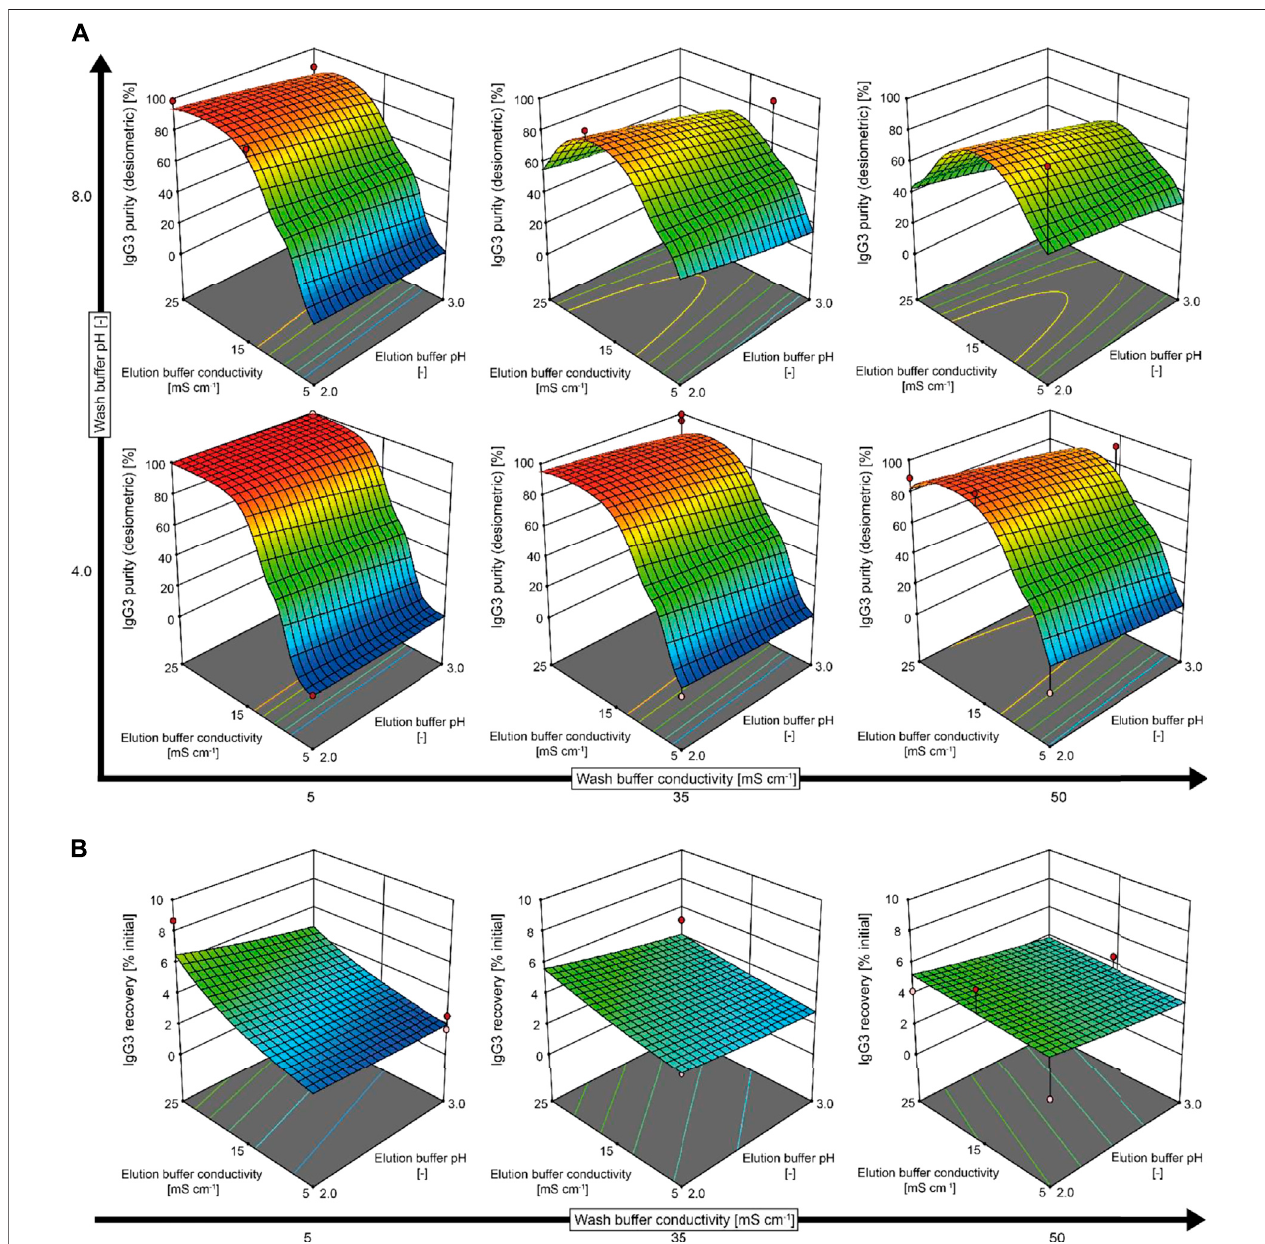
FIGURE3| ModelspredictingtheeffectsofthewashandelutionbufferpHandconductivityonIgG3purityandrecoveryafterproteinGchromatography(D-optimal design with 30 runs). (A) IgG3 purities after protein G chromatography were assessed by densiometric analysis of silver-stained LDS gels using the software AIDA. (B) IgG3 recoveries were derived from IgG3 concentrations measured in the feed and elution fractions using a protein G-coated SPR sensor. Miniaturized spin columns containing resuspendable protein G resin were used for puri fi cation. A contact time of 2 min was used for all chromatography steps. Red dots represent experimental data. Note: the model surface appears distorted around 15 mS cm − 1 because there are additional levels in that region.